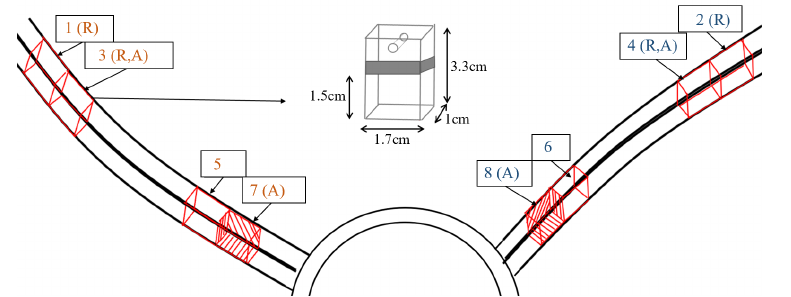
Figure 1. Sample selection from the sand-cast lattice, with a sample dimension of 3.3 cm × 1.7 cm × 1 cm for the chemical stability measurements. A thin coating line of nitrocellulose in butyl acetate starting 1.5 cm from the bottom of the samples were incorporated to avoid excess corrosion at the